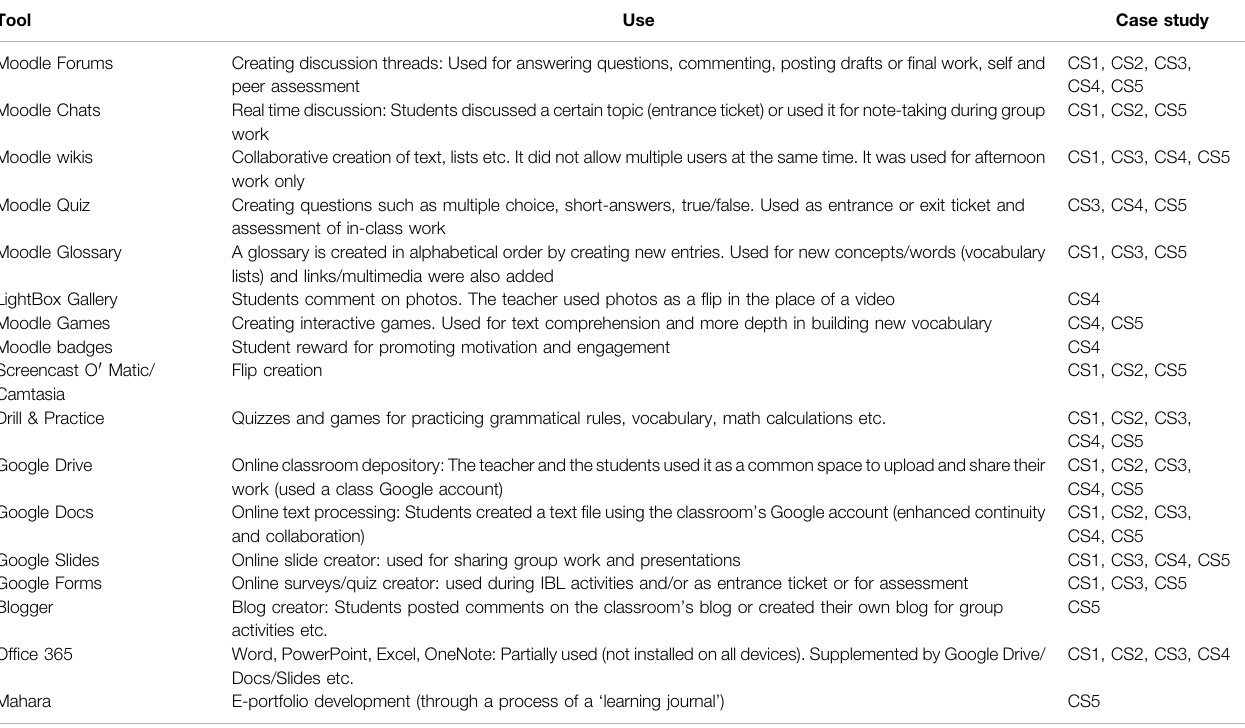
TABLE 2 | Digital tools used during FC